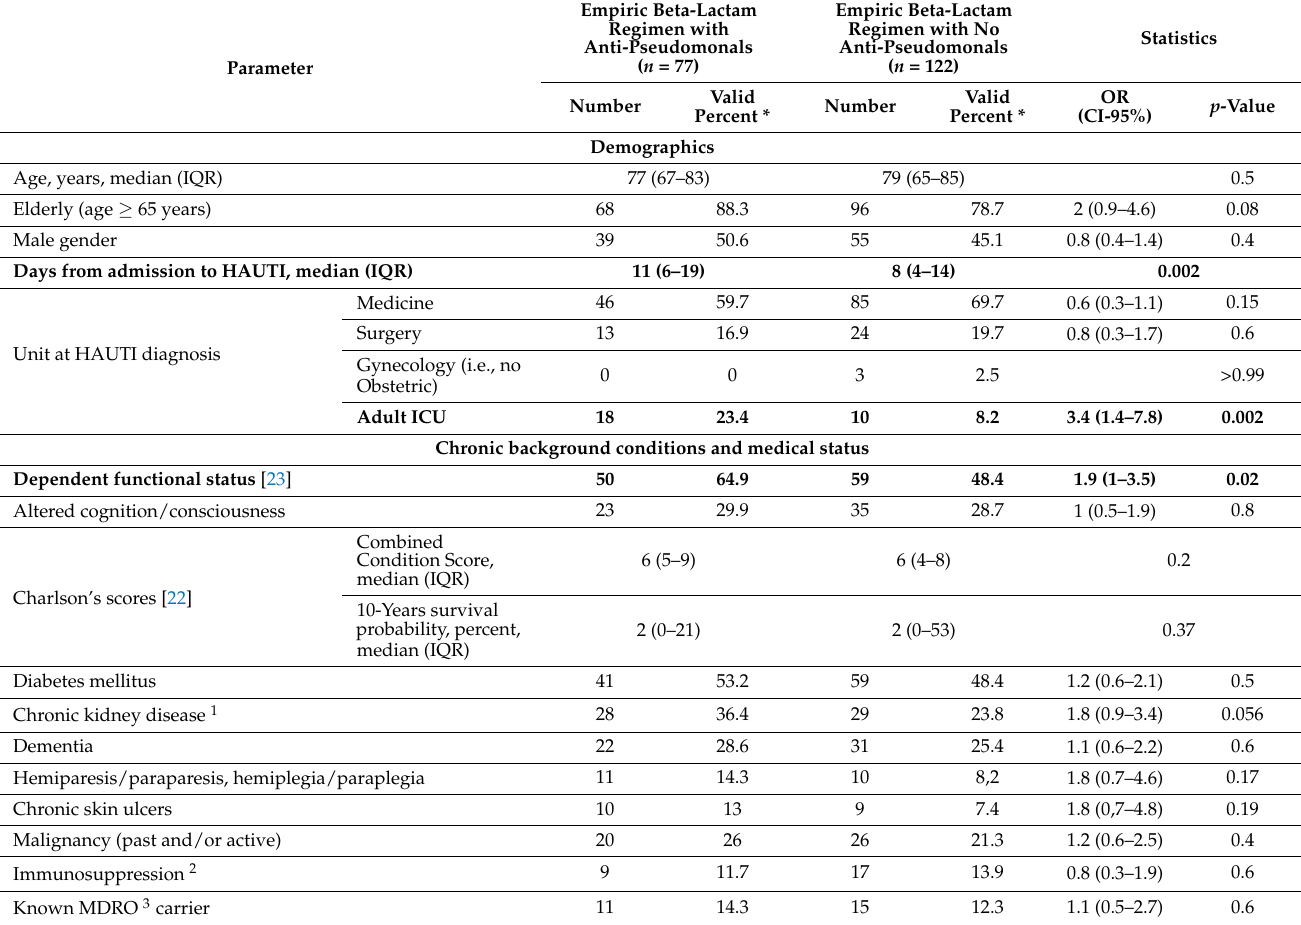
Table 3. Sub-analysis of patients with HAUTI who received a beta-lactam-only regimen.